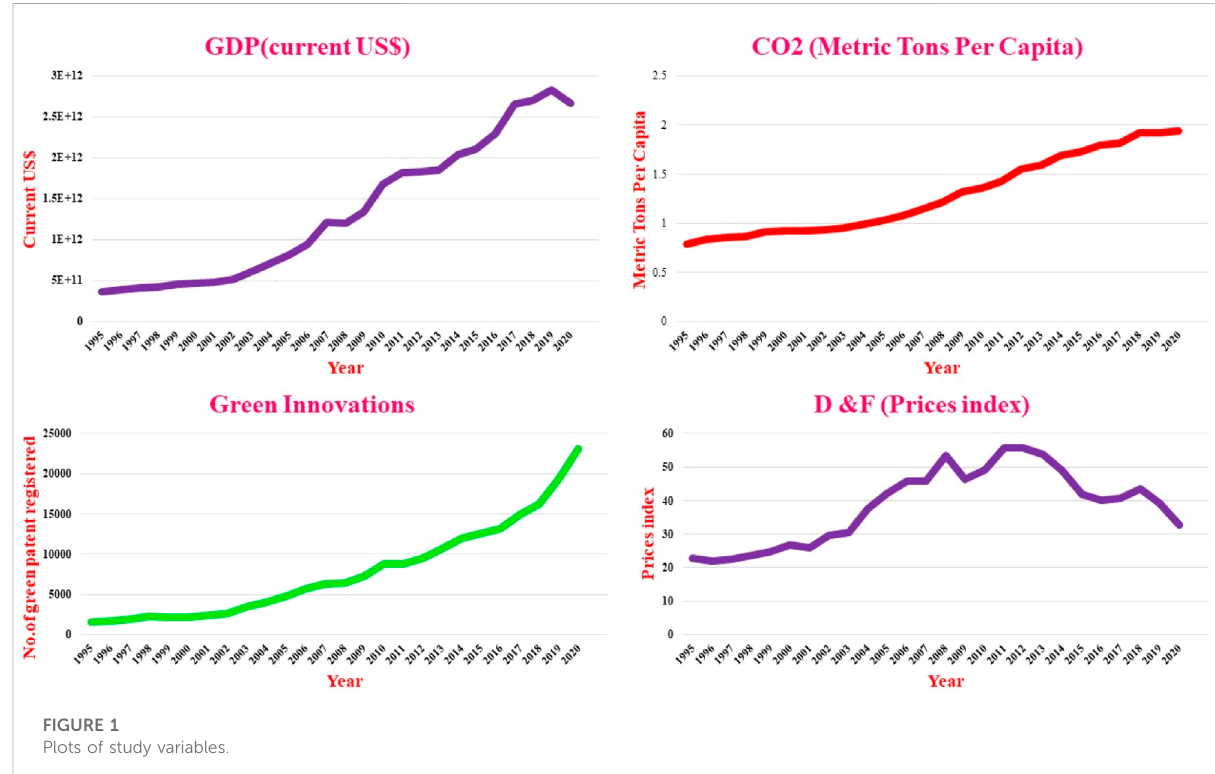
FIGURE 1 Plots of study